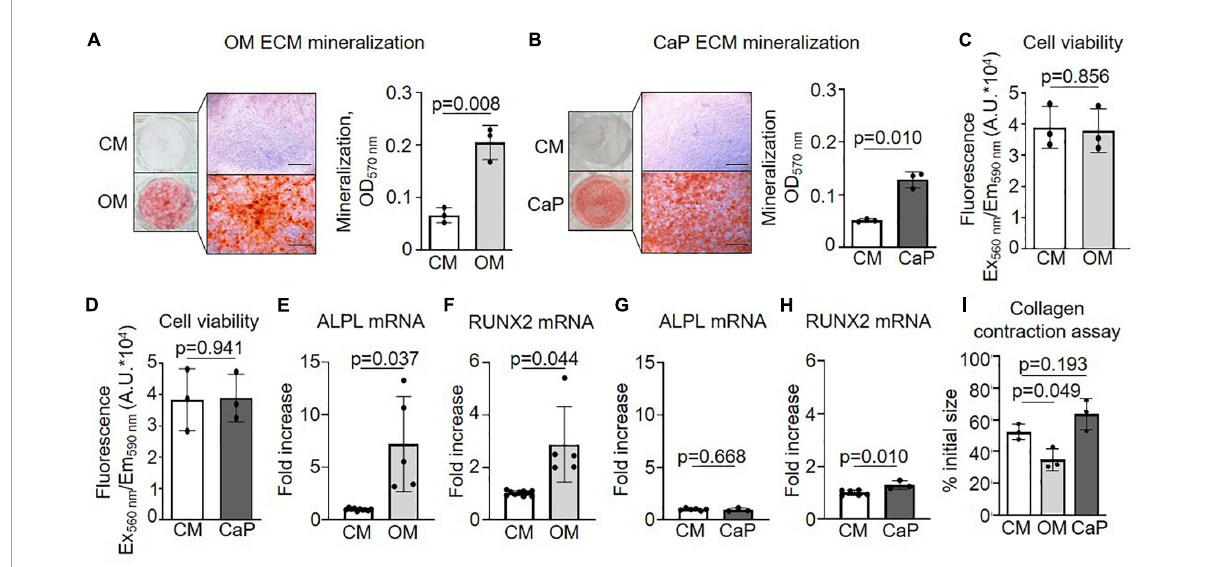
FIGURE1 Characterization of osteogenic medium (OM) and calcium phosphate (CaP)-induced calcification of primary coronary artery smooth muscle cells (pSMCs). (A) pSMCs were cultured in control medium (CM) and OM for 21 days or (B) CaP for 7 days. Representative images of extracellular matrix (ECM) mineralization were detected by alizarin red S staining and eluted staining quantified by assessing the optical density at 570 nm. Scale bar: 1,000 µ m. n = 3 (C) Effect of OM and (D) CaP-induced calcification on cell viability assessed by AlamarBlue assay (Fluorescence Ex 560 nm/Em 590 nm) on day 21 for OM and day 7 for CaP. n = 3. (E–H) ALPL and RUNX2 mRNA expression for (E,F) OM-calcified pSMCs (day 7) and (G,H) for CaP-calcified pSMCs (day 3). (I) Collagen contraction assay at day 5. n = 3–5. Error bars indicate ± SD. Each n indicates